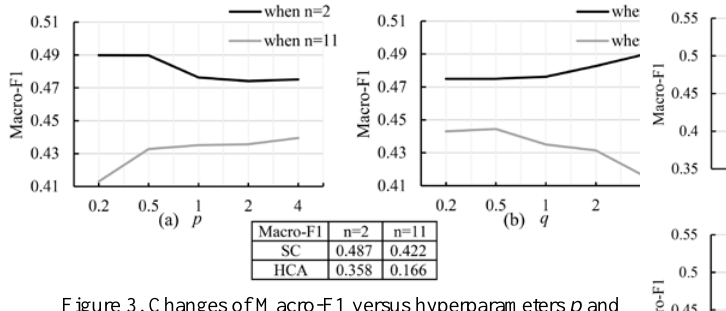
Figure 3. Changes of Macro-F1 versus hyperparameters p and q : when the search strategy is more inclined to BFS (p<1 or q >1), Macro-F1 scores of structural equivalence get higher and when the search strategy is more inclined to DFS (p>1 or q<1),